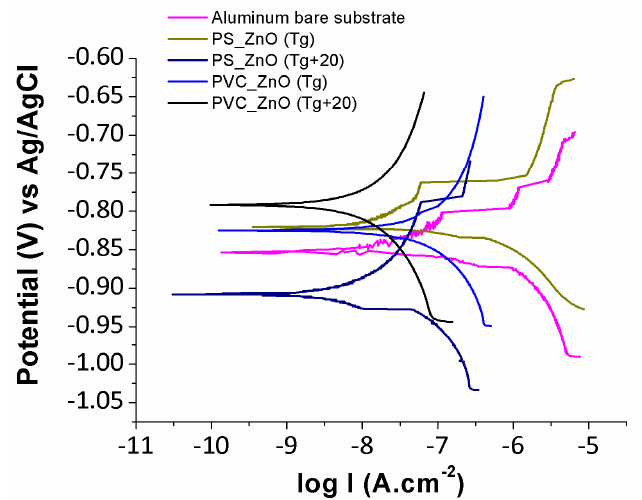
Figure 14. Tafel plots corresponding to the Al bare substrate and the Al samples coated with electrospun PS-ZnO and PVC-ZnO electrospun fibres which have been thermally treated and tested in 3.5 wt% NaCl aqueous solution. Reprinted with permission of